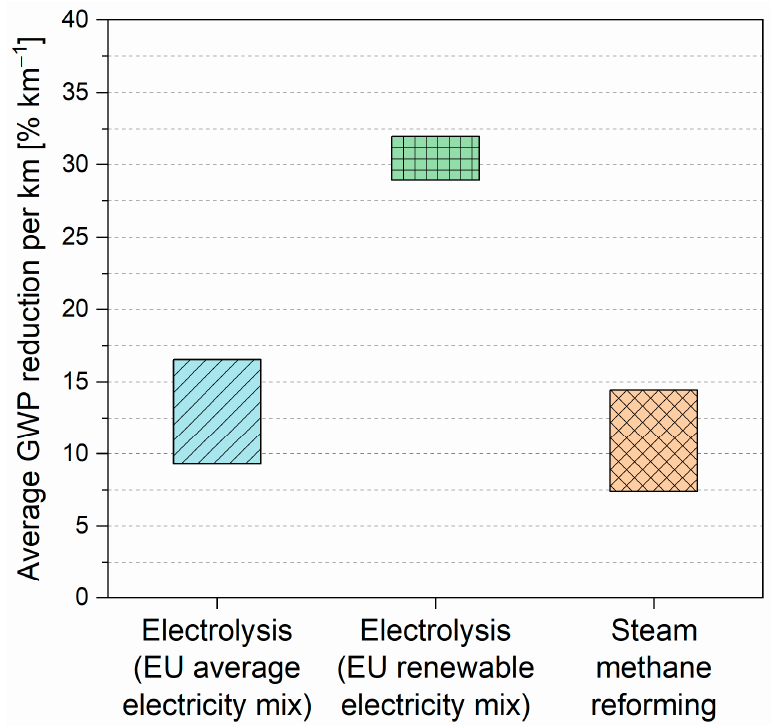
Figure 4. Global warming potential reduction (%) resulting from the substitution of PTFE-based GDMs with FEP-based ones. The GWP reduction is calculated as the percentage decrease with respect to the GWP of PTFE-based GDMs (assumed as a reference case). Floating bars illustrate the range of reduction for each hydrogen production pathway, obtained by varying the initial fuel consumption and considering different impacts for vehicle production and disposal phases.